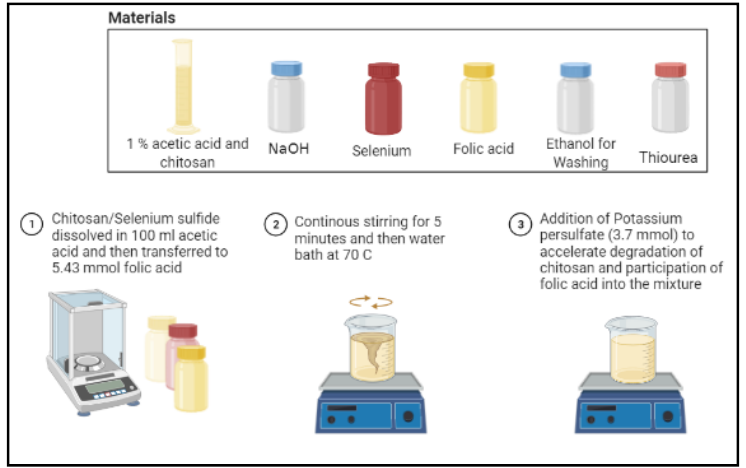
Figure 1. Synthesis of selenium/chitosan-folic acid complex.